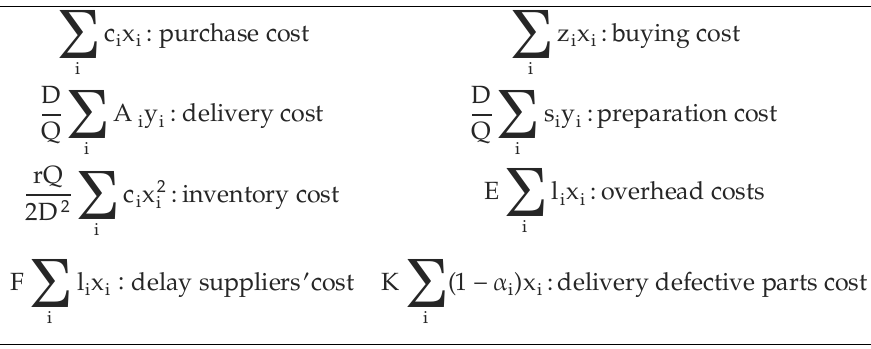
Table 1. The costs of the mentioned